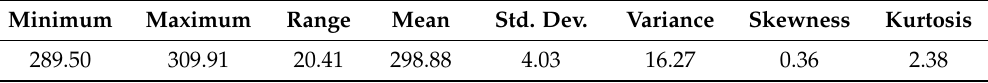
Table B4. Statistics of the dry-bulb temperature (set to air inlet temperature) distribution [K].